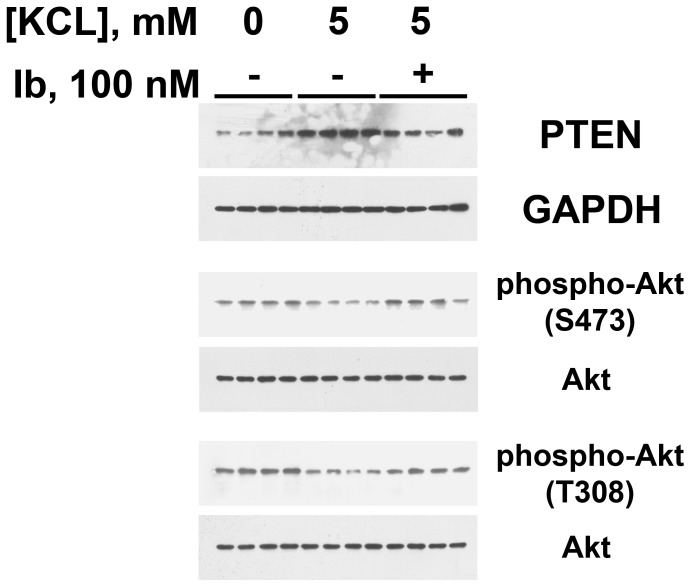
The effect of ambient [KCl] on endothelial PTEN and phosphorylation of Akt at S473 and T308 was dependent upon BKCa activity.In these experiments, each lane represents a single experiment. Overnight incubation of HUVEC in medium containing [KCl], 5 mM, and iberiotoxin (Ib), 100 nM, reduced PTEN levels (top panel) to those observed in cells incubated in medium containing 0 mM [KCl] (PTEN/GAPDH ratios for [KCl] 0, [KCl] 5 and [KCl] 5 plus Ib were 0.53±0.07, 0.99±0.05, and 0.61±0.07; p-value <0.05). Incubation of HUVEC in medium containing [KCl], 5 mM, reduced phospho-Akt(S473) (middle panel), compared to values obtained from HUVEC incubated in medium without KCl; this decrease was reversed by the addition of Ib (phospho-Akt(S473)/Akt ratios for [KCl] 0, [KCl] 5 and [KCl] 5 plus Ib were 0.50±0.04, 0.17±0.03, and 0.48±0.05; p-value <0.05). Incubation of HUVEC in medium containing [KCl], 5 mM, reduced phospho-Akt(T308) (bottom panel), compared to values obtained from HUVEC incubated in medium without KCl; addition of Ib increased phospho-Akt(T308)/Akt ratios. For [KCl] 0, [KCl] 5 and [KCl] 5 plus Ib, the ratios were 0.65±0.02, 0.23±0.02, and 0.46±0.02; p-value <0.05.